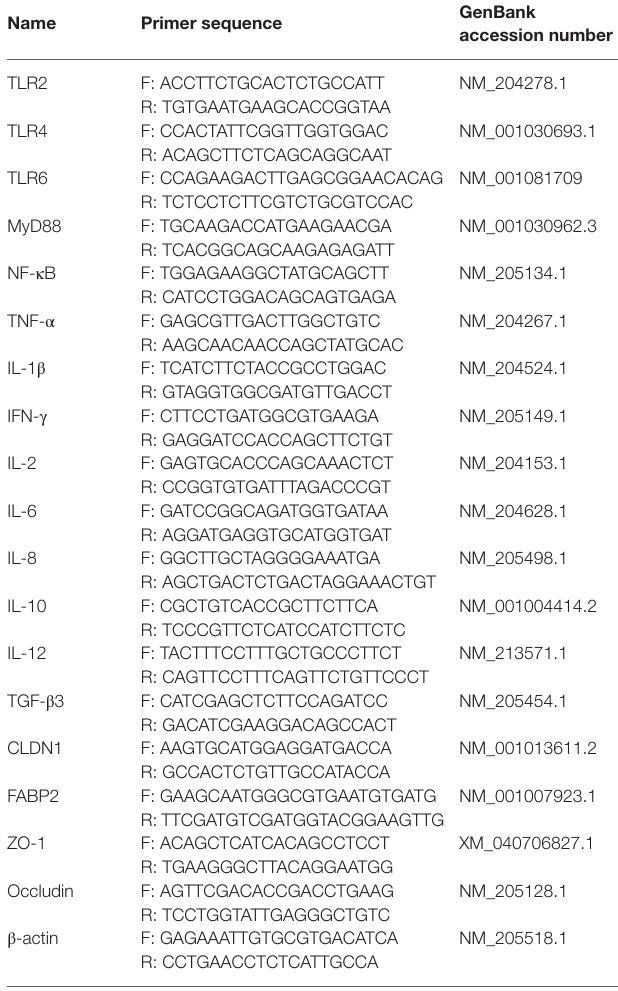
TABLE 1 | Sequences of the oligonucleotide primers used for quantitative real- time PCR.